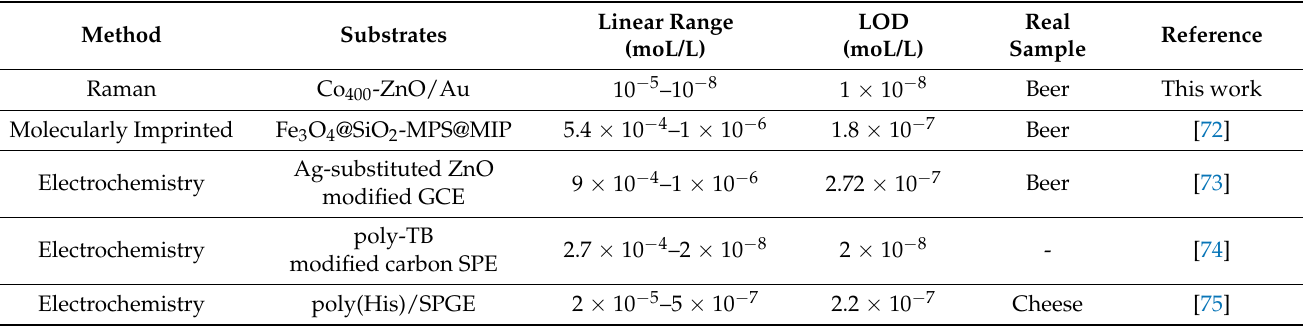
Table 2. Comparison with other methods for the determination of Tyramine.